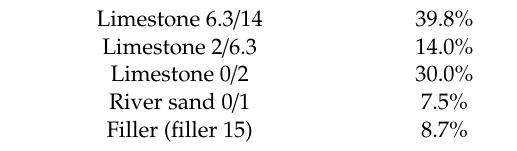
Table 2. Mixture composition (by aggregate